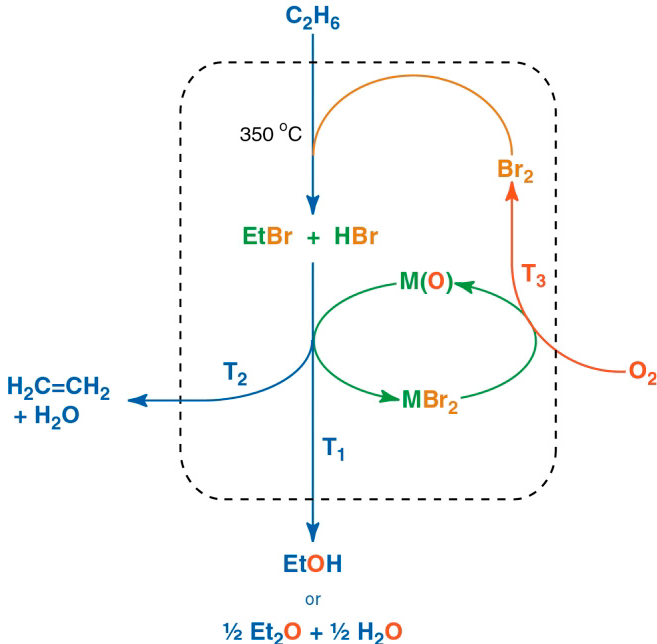
Figure 4. An example of a multi-step process involving halogenation—generation of ethanol or diethyl-ether from ethane. Reproduced from [72] with permission from the Centre National de la Recherche Scientifique (CNRS) and The Royal Society of Chemistry.